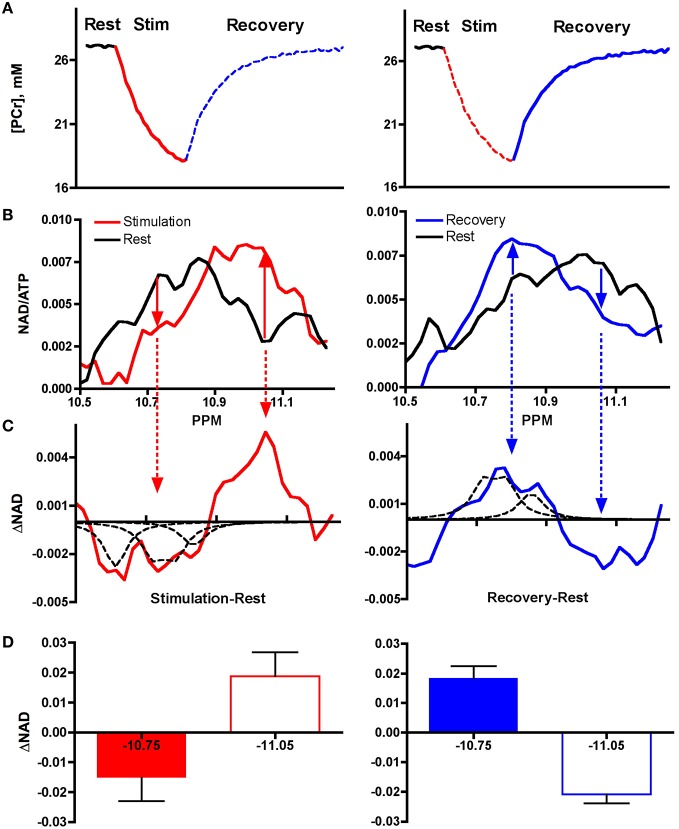
Spectral changes during stimulation and recovery from exercise. (A) Exercise elicits elevated ATP use (PCr decline, red line) and oxidative phosphorylation (PCr re-synthesis, blue line). (B) Altered 31P Spectra in stimulation (red) and recovery from exercise (blue) vs. resting muscle (black). (C) Subtraction of spectra region in resting (black) vs. stimulated muscle (red) and vs. recovering (blue) muscle reveals reciprocal changes in −10.75 ppm and in −11.05 ppm regions. The dashed peaks represent the resonances for the chemical metabolites in solution: NADH (−10.6 ppm), NAD+ (−10.75 ppm), and NADP+ (10.83 ppm). (D) Reciprocal changes in integrated areas of −10.75 ppm and −11.05 ppm regions.